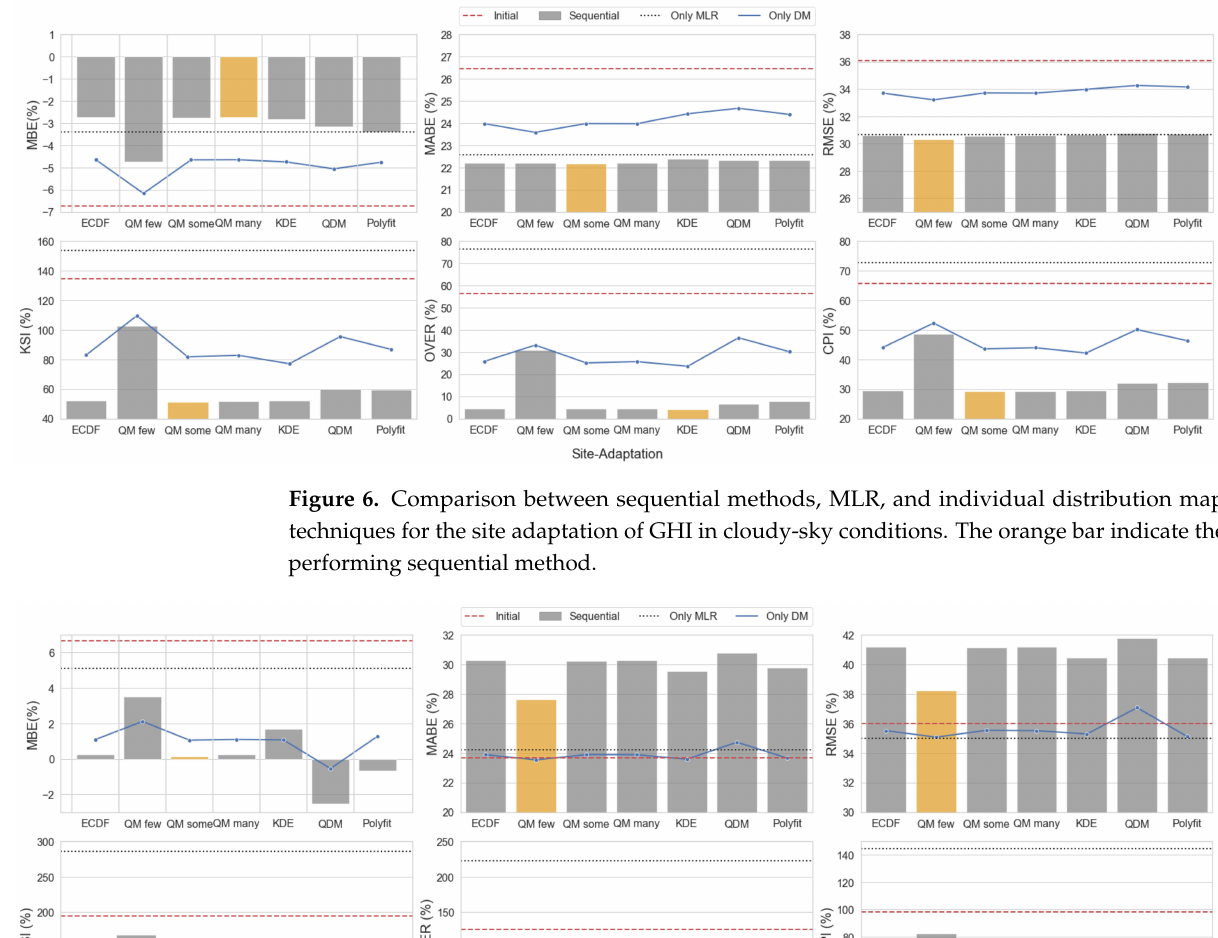
Figure 5. Comparison between sequential methods, MLR, and individual distribution mapping techniques for the site adaptation of GHI in clear-sky conditions. The orange bar indicate the best performing sequential method.